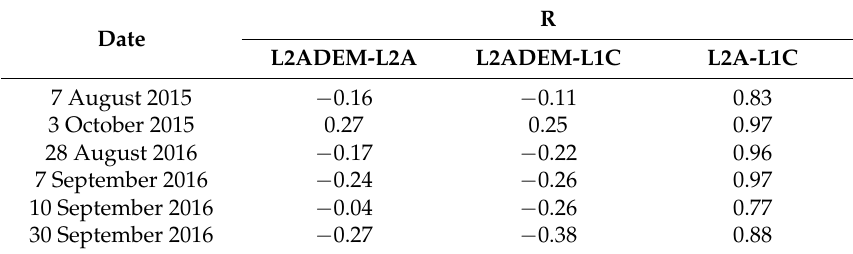
Table 10. Correlation between the abundance of treefall gap rasters on different data types on different dates on